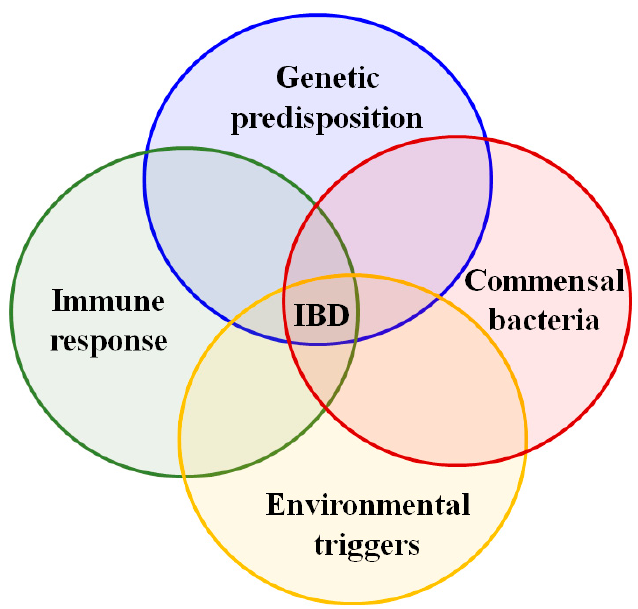
Figure 1. Etiology theories in inflammatory bowel disease (IBD), adapted from [9,10].